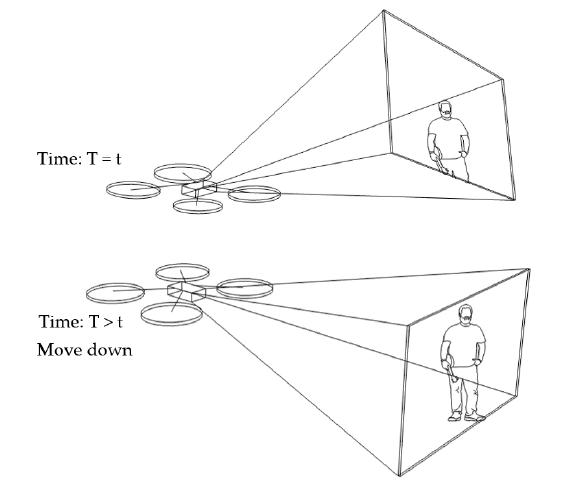
Figure 10. Human motion tracking when the drone moves